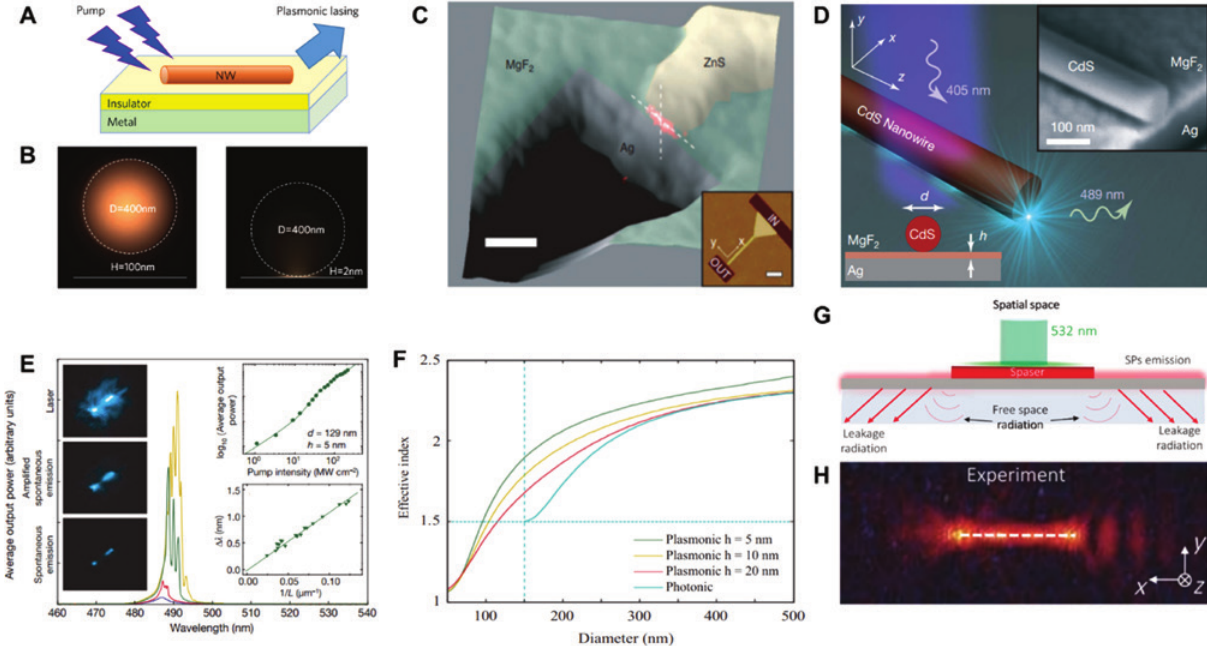
Figure 2: Demonstration of a plasmonic NW